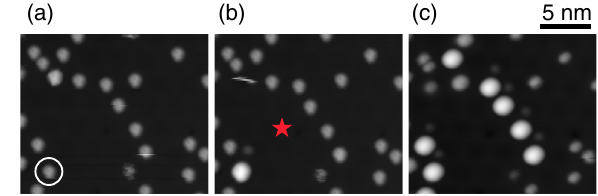
FIG. 7. Manipulation procedures for H removal from Dy adatoms. We show a sequence of STM images acquired on a Dy on gr = Ir ð 111 Þ sample that was exposed to gas desorbing from the cryostat walls upon heating up the STM. (a) Reference STM image: A voltage ramp ( − 0 . 5 to − 2 V, closed feedback loop) is then applied on the encircled hydrogenated atom to clean it, as is visible in panel (b). (b) A-4 V voltage pulse (50 ms, open feedback loop) applied on the graphene substrate at the location indicated by the red star. (c) After the voltage pulse, several clean ¼ − 0 . 5 V, Dy adatoms are present. Parameters for all images: V t ¼ 20 pA, T ¼ 6 . 5 K, Θ ¼ 0 . 5% ML, W tip. I t Dy